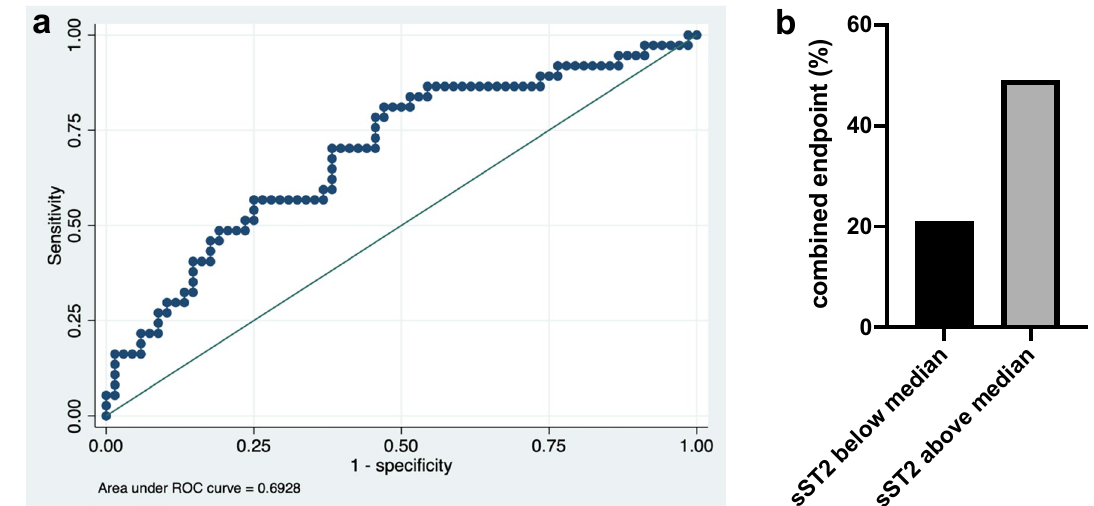
Figure 2. ( a ) ROC (receiver operating characteristic) curve for diagnostic performance of sST2 24 h after resuscitation for the primary end point (death or CPC > 2 at 6 months; optimal cut-off value 46.15 ng/ml; sensitivity 81%, specificity 53%, AUC 0.69). ( b ) Bar graph of combined end-point (death or CPC > 2 after 6 months) in patients with sST2-levels below and above the median (53.42 ng/ml) 24 h after ICU